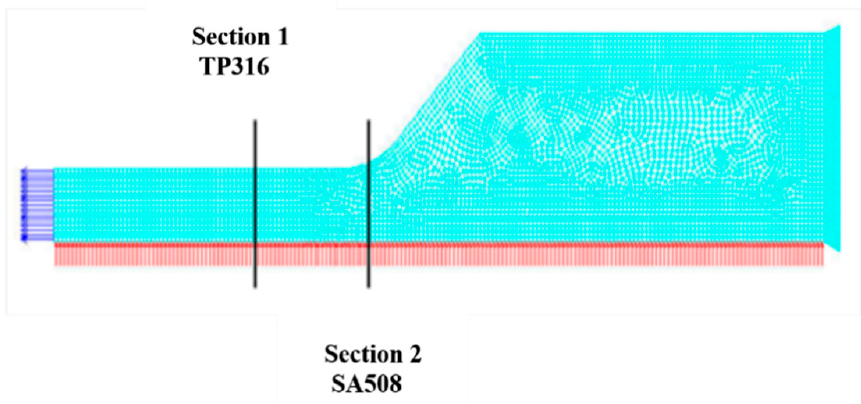
Figure 3. Finite element model with load, boundary conditions, and target cross-sections. Table 1. Transient data of temperature, pressure, and external load vs. time in sample 1.